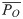
GBC hospitalization- and patient-specific risk distributions.Observed hospitalization-level risk is plotted against predicted risk (top row) and patient-level mean observed risk against mean predicted risk (bottom row). Distributions of predictions PP are shown at the hospitalization and patient level. At patient level, distributions that are difficult to discern from the scatter plot are shown. In the scatter plots, alpha level is 0.05 and the red calibration curve corresponds to all hospitalizations or to patients who had either mean risk over hospitalizations of 1 or 0. The calibration curves are computed according to the macro-averaged predicted output per hospitalization or patient over the 50 iterations of 5 fold CV (over 250 total folds). Ideal calibration is the dotted black diagonal. Histograms have 1000 bins to give necessary resolution. PO = observed risk per hospitalization, PP = predicted risk per hospitalization, PO¯ = mean observed risk over hospitalizations, PP¯ = mean predicted risk over hospitalizations.